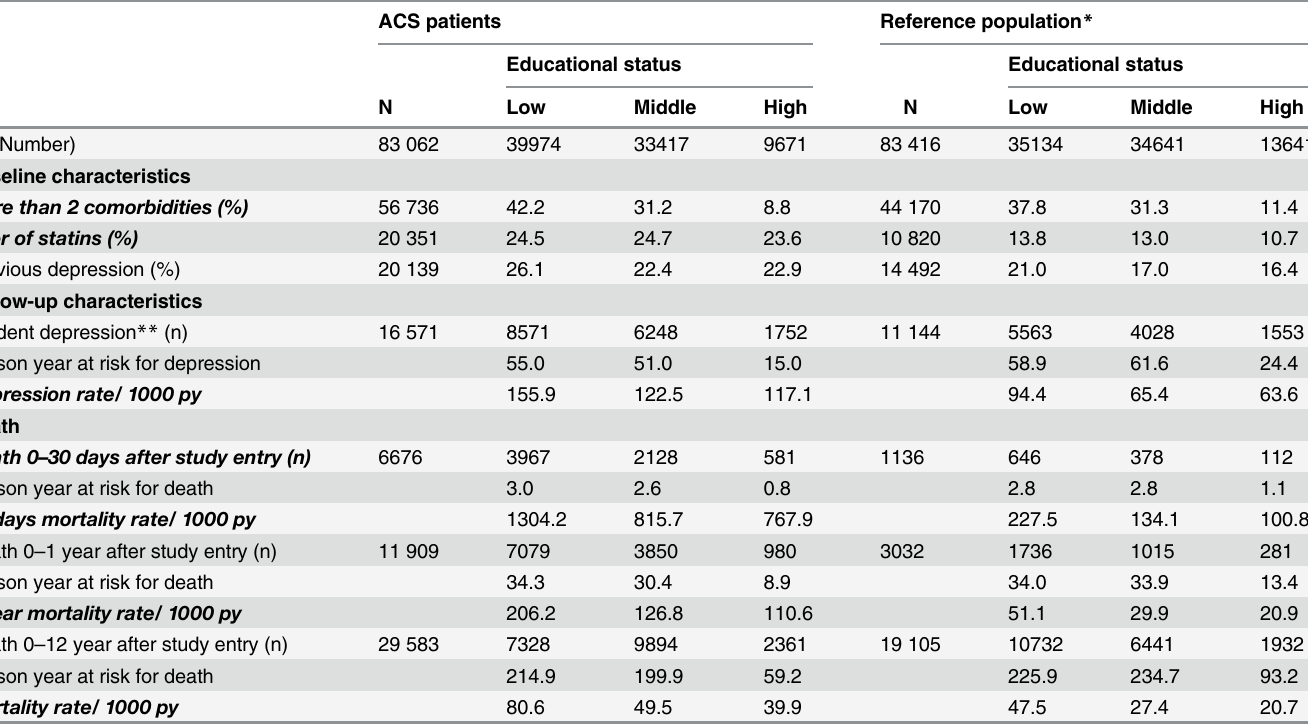
Table 2. Characteristics of patients admitted first time with acute coronary syndrome (ACS) and a reference population in Denmark. According to educational status at study